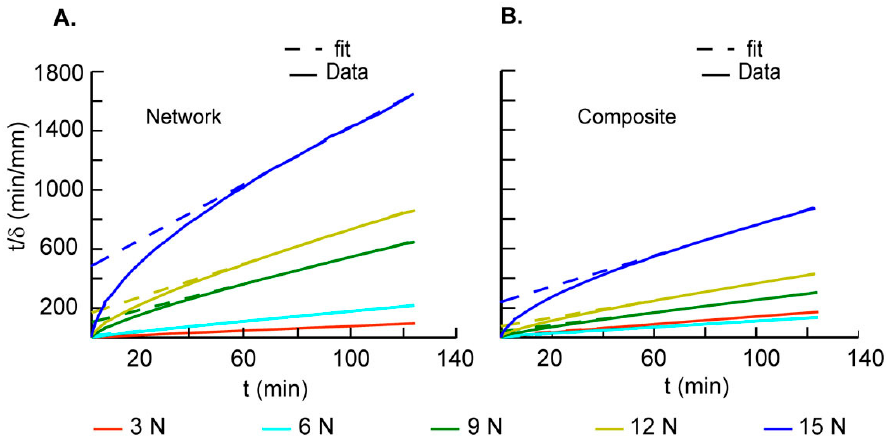
Figure 4. Data are shown for a representative ( A ) network and ( B ) composite specimen tested using confined creep loading as described earlier. Fits to rectangular hyperbola method ( r 2 > 0.98) were obtained and used to assess differences in the consolidation behaviours. Table 2. Consolidation coefficients ( C v mm 2 /min), constrained moduli ( E c kPa), and hydraulic permeability ( k m 4 /Ns) are shown for network and composite scaffolds at the different